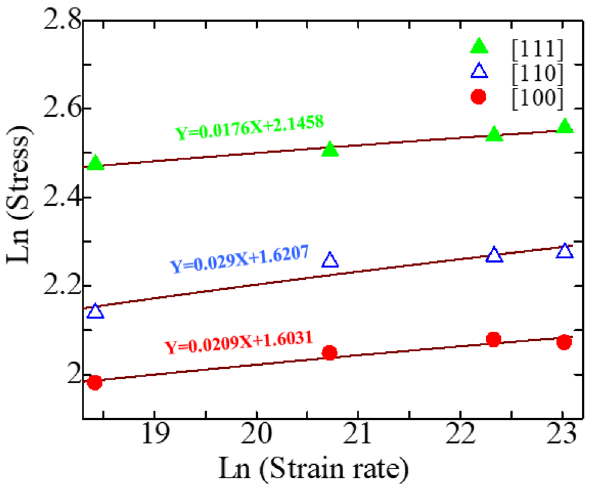
Figure 11. The strain-rate sensitivity of zinc-blende ZnSe NWs along three crystal orientations at 300